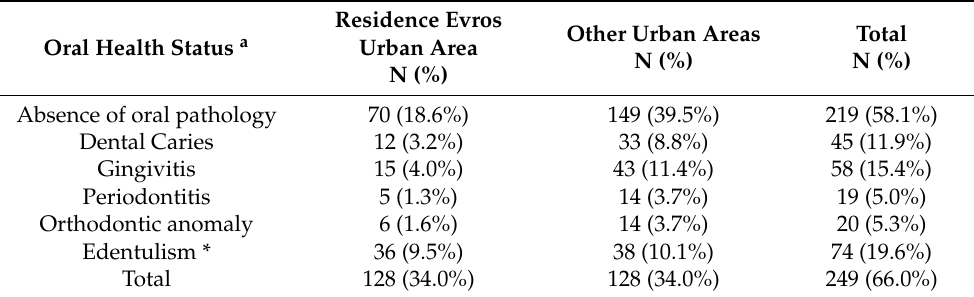
Table 6. Place of urban residence of adults (Evros/other areas) in relation to the condition the oral health.